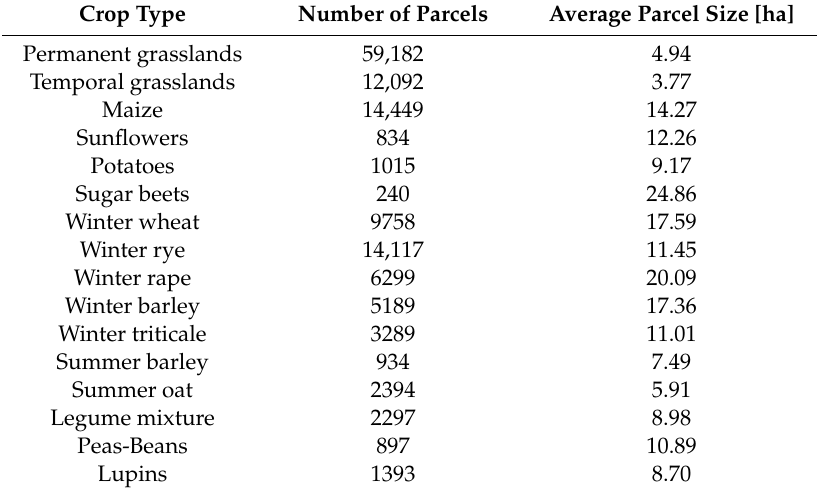
Table 1. Overview information for the crop types considered in this